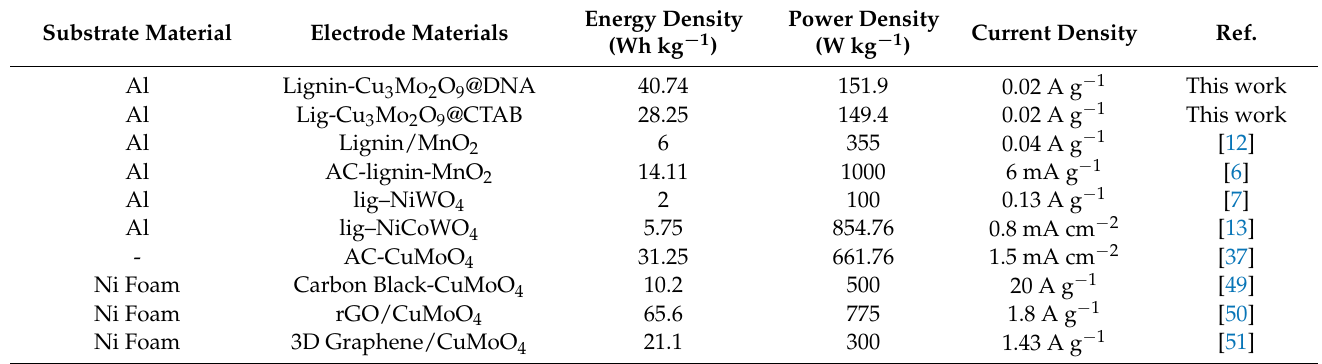
Table 1. Comparison of energy and power densities of the current work with reports in the